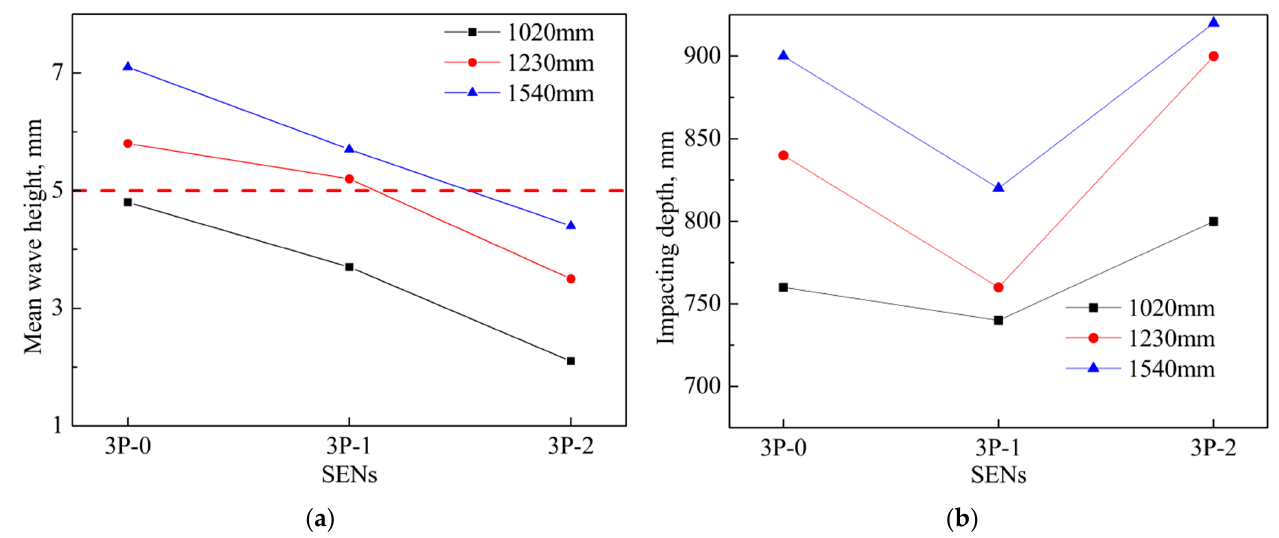
Figure 7. ( a ) Mean wave height near narrow face and ( b ) impacting depth using different SENs.